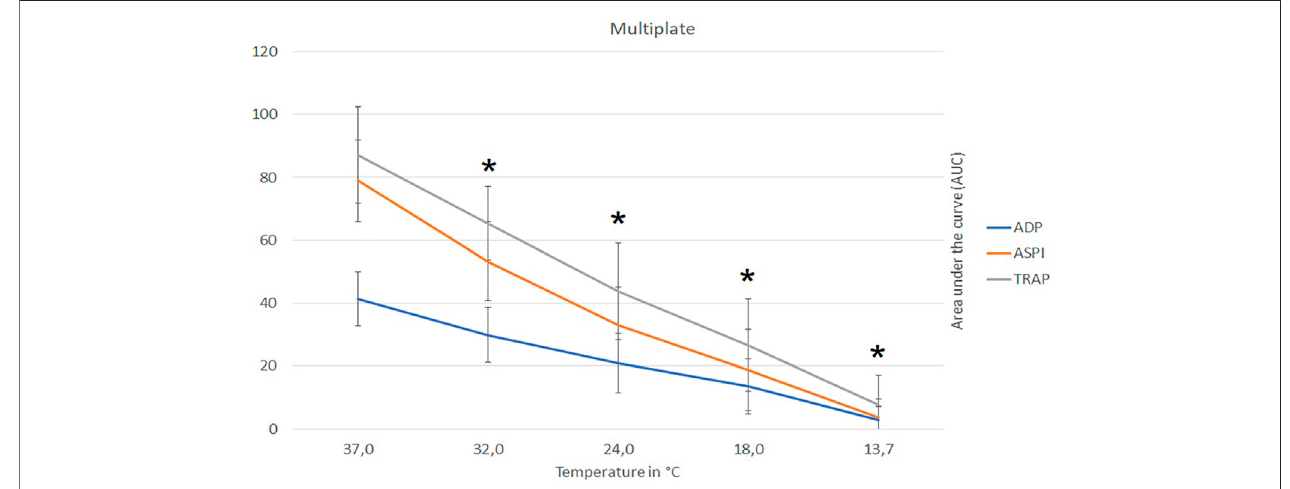
FIGURE 3 | In fl uence of temperature (x-axis, temperature in degrees Celsius) on platelet function (y-axis, AUC area under the curve) assays ADP, ASPI and Trap, respectively, as measured with multiple-electrode aggregometry (MULTIPLATE). Figure shows mean values with respective 95% con fi dence interval. AUC, area under the curve; ADP, adenosine diphosphate; ASPI, arachidonic acid; TRAP, thrombin receptor-activating peptide; * indicates signi fi cant differences to baseline at 37 ° C ( p -values < 0.05).